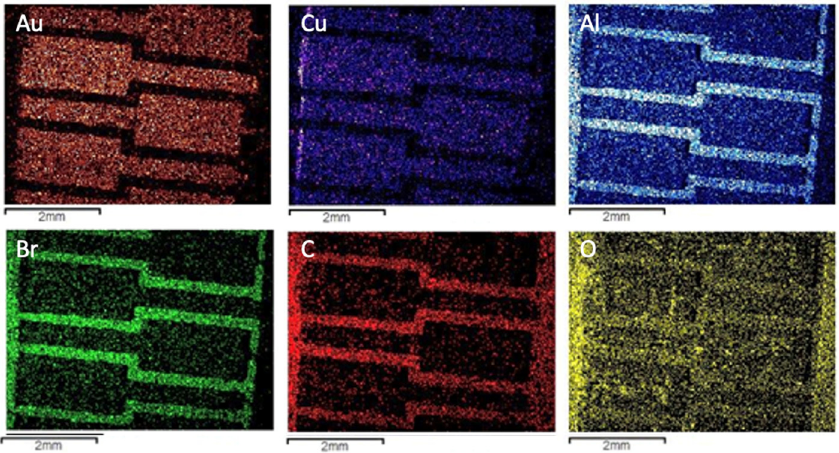
Figure 4. Chemical mapping of the most relevant elements detected in the microanalysis of the dark and bright areas of the Type 1 WEEE sample.